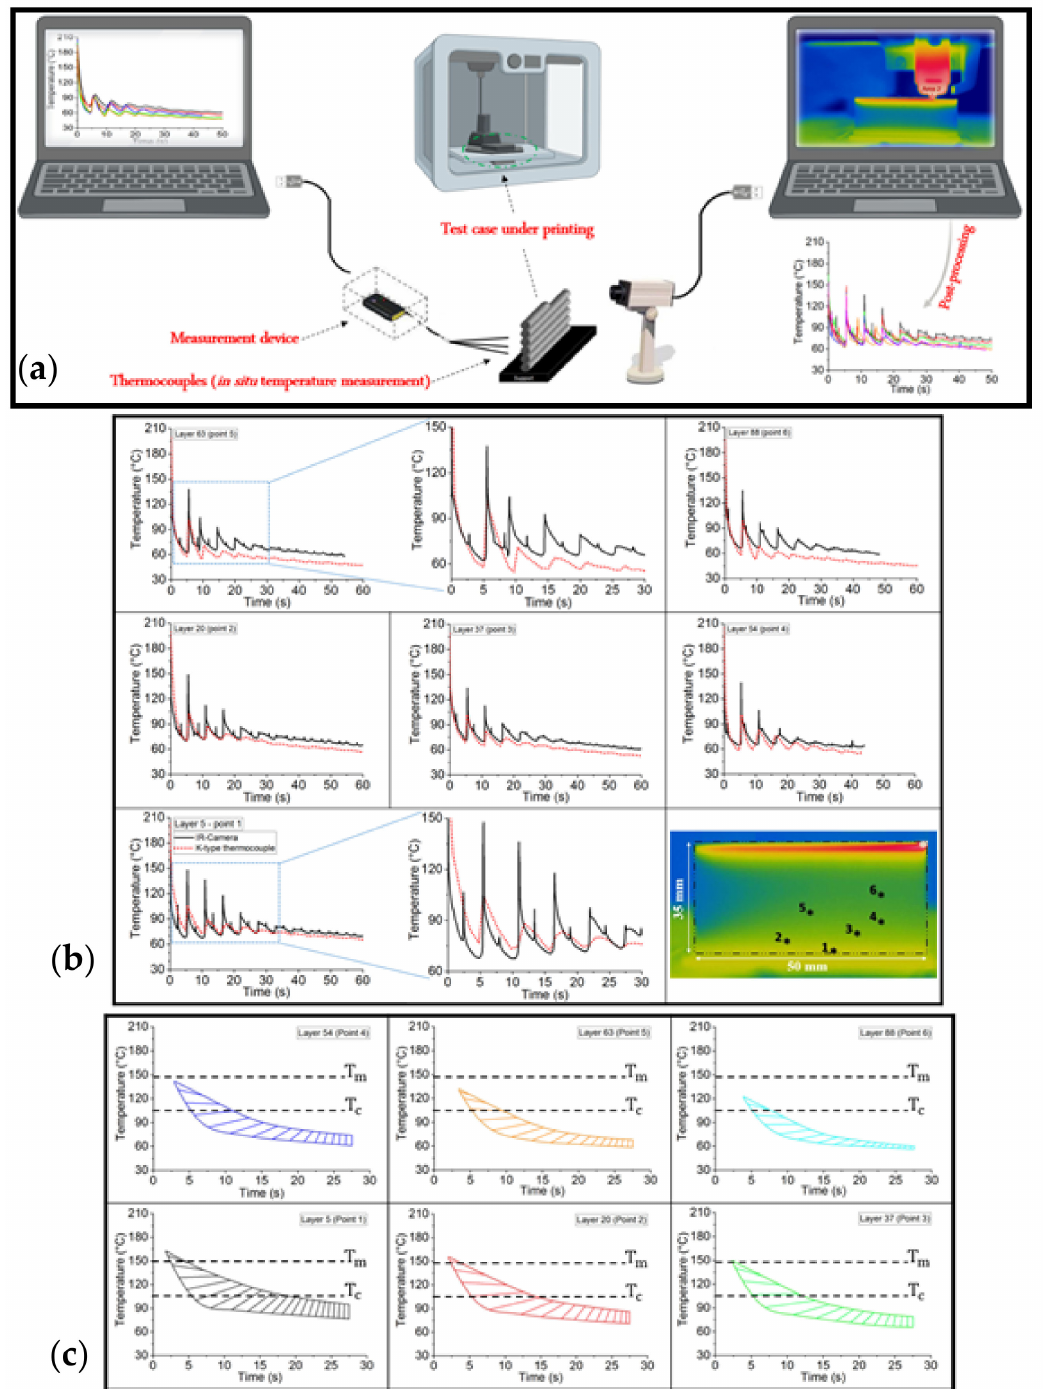
Figure 14. Representation of ( a ) experimental set-up, ( b ) global–local temperature profile at specific points, and ( c ) temperature contour of the peak values (reprinted with permission from